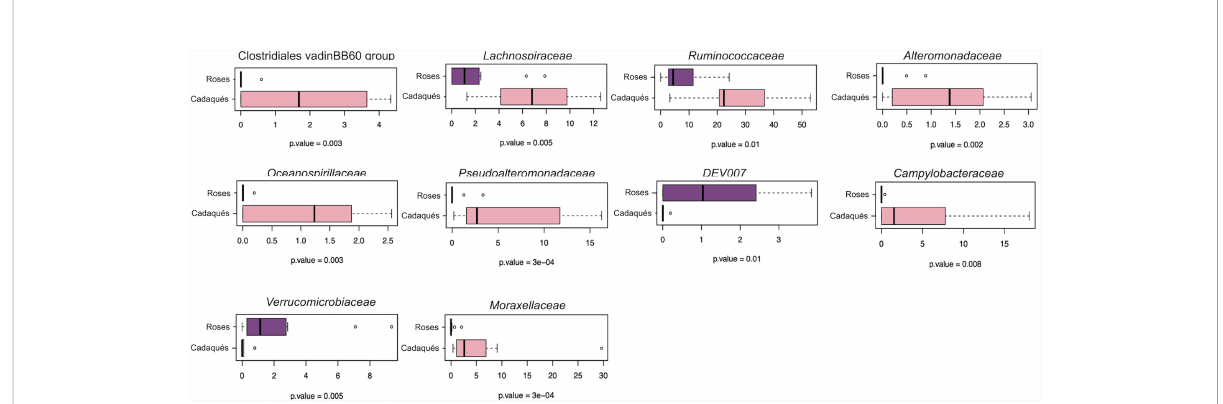
FIGURE 6 Microbial families responsible for signi fi cant compositional differences between the A. viridis microbiota in Cadaque ́ s and Roses samples at the Cap de Creus site. Box-and-whisker plots showing the relative abundance of bacterial families whose differential distribution was signi fi cantly different in the A. viridis -associated microbiota in Cadaque ́ s ( “ lightpink ” ) and Roses ( “ orchid4 ” ) sampling sites according to MaAsLin2. The central box represents the distance between the 25th and 75th percentiles. The median is marked with a black line. Whiskers identify the 10th and 90th percentiles. P-values are reported below each box plot (Wilcoxon rank-sum test controlled for multiple testing using FDR).